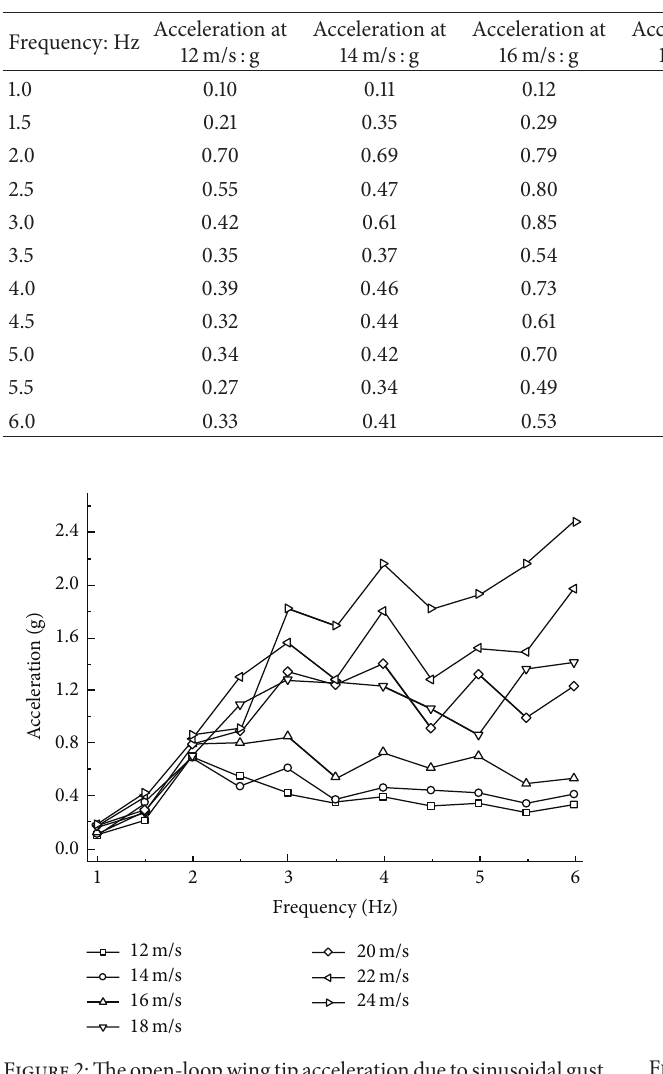
Figure2:Theopen-loopwingtipaccelerationduetosinusoidalgust in the wind tunnel test.